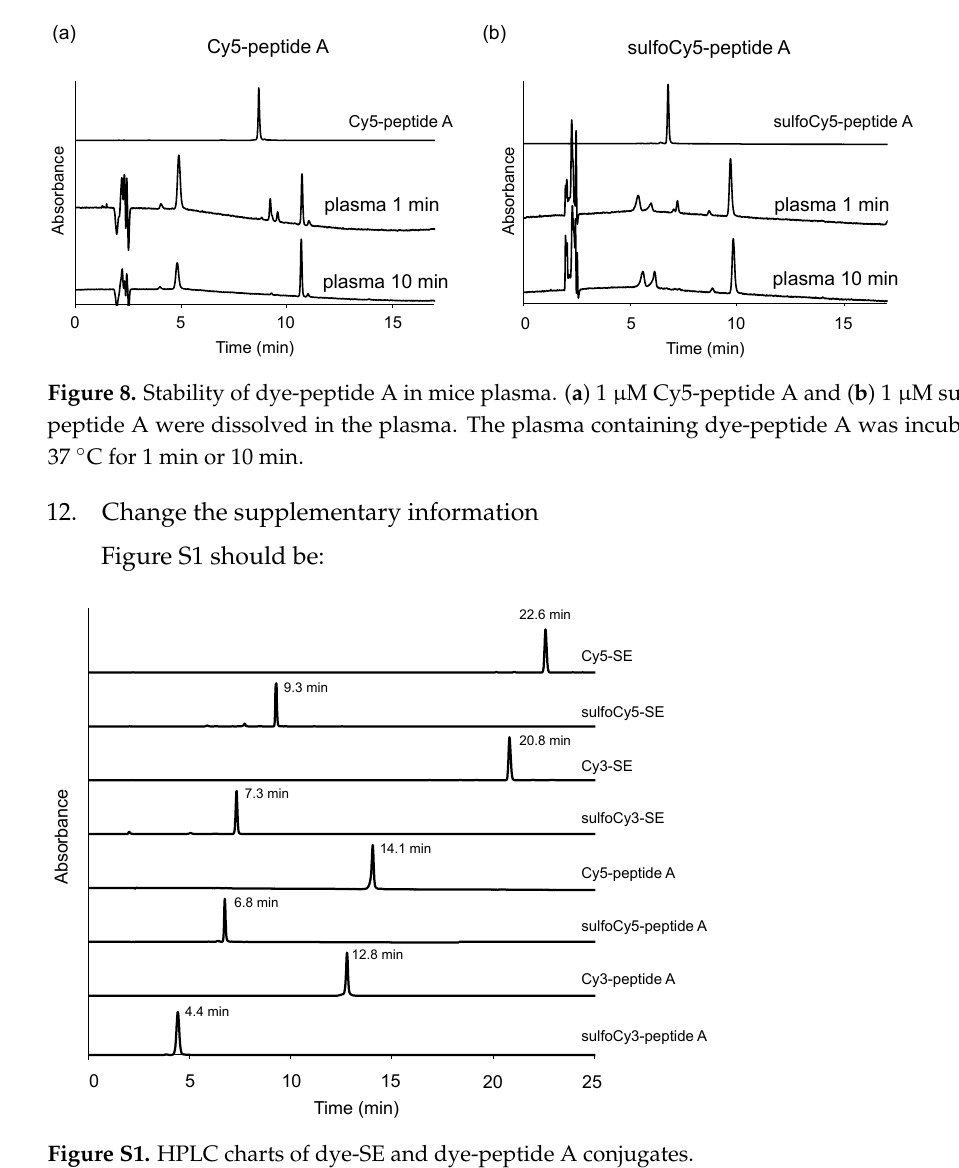
Figure S1. HPLC charts of dye-SE and dye-peptide A conjugates.